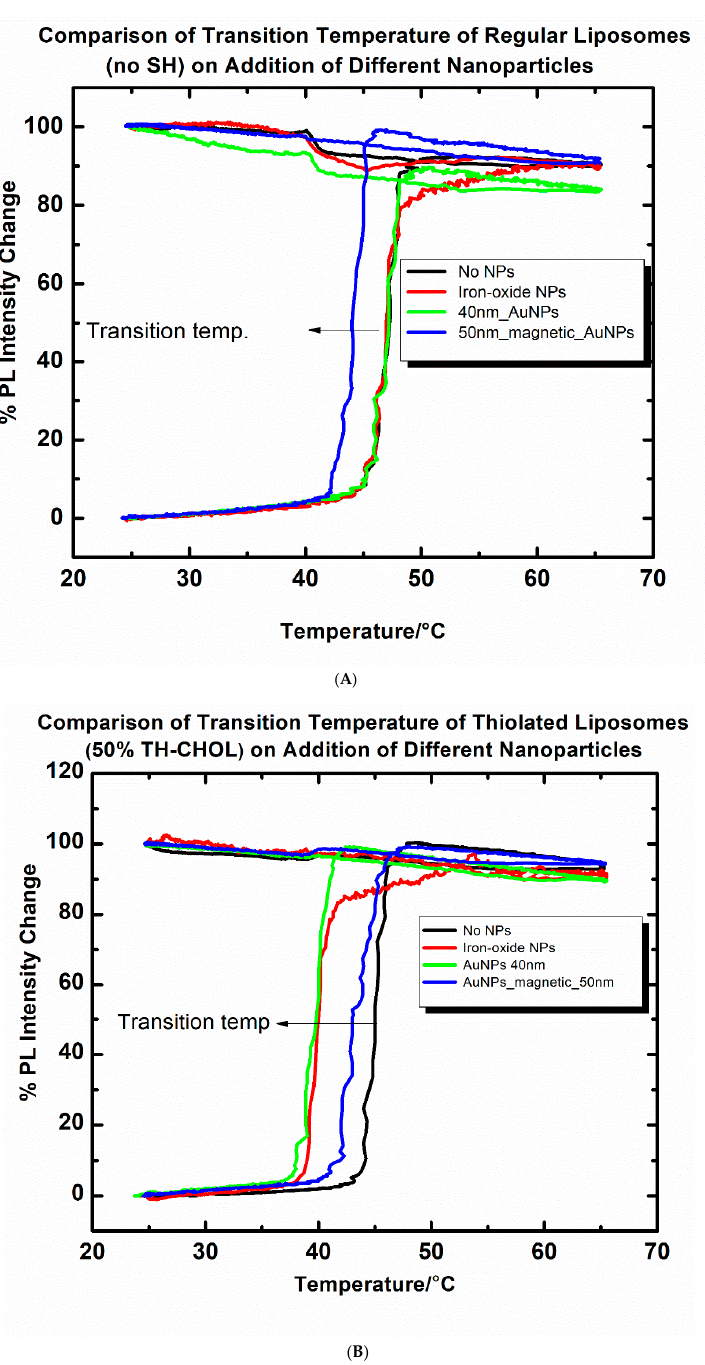
Figure 4. ( A ) Comparison of transition temperatures of regular (non thiolated) liposomes with various nanoparticles (see text for detail). Please, note that the PL intensity is normalized to 0–100% at 25 °C for comparison. ( B ) Comparison of transition temperatures of thiolated (with 50% Thiolated cholesterol) liposomes with various nanoparticles (see text for detail). Please, note that the PL intensity is normalized to 0–100% at 25 °C for comparison.